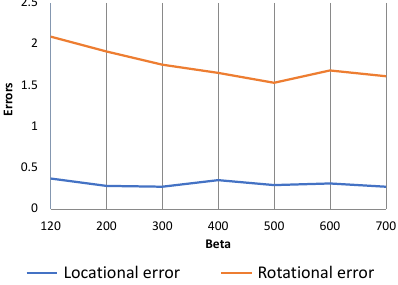
Figure 5. The variation of locational and rotational errors with β